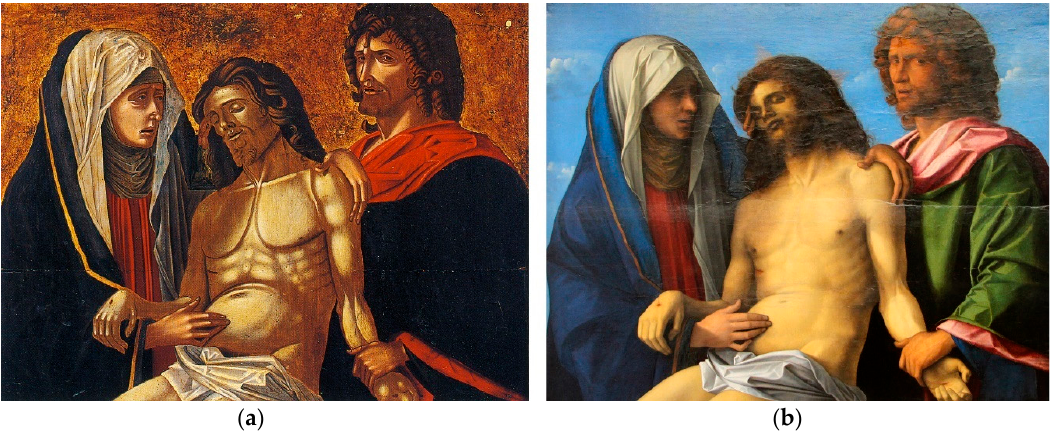
Figure 10. ( a ) Pietà after Giovanni Bellini , San Marino, Museo di Stato (taken from Pasini 2000, Fig. 57); ( b ) Giovanni Bellini, Pietà , ca. 1495, Berlin, Gemäldegalerie (image in the public domain).